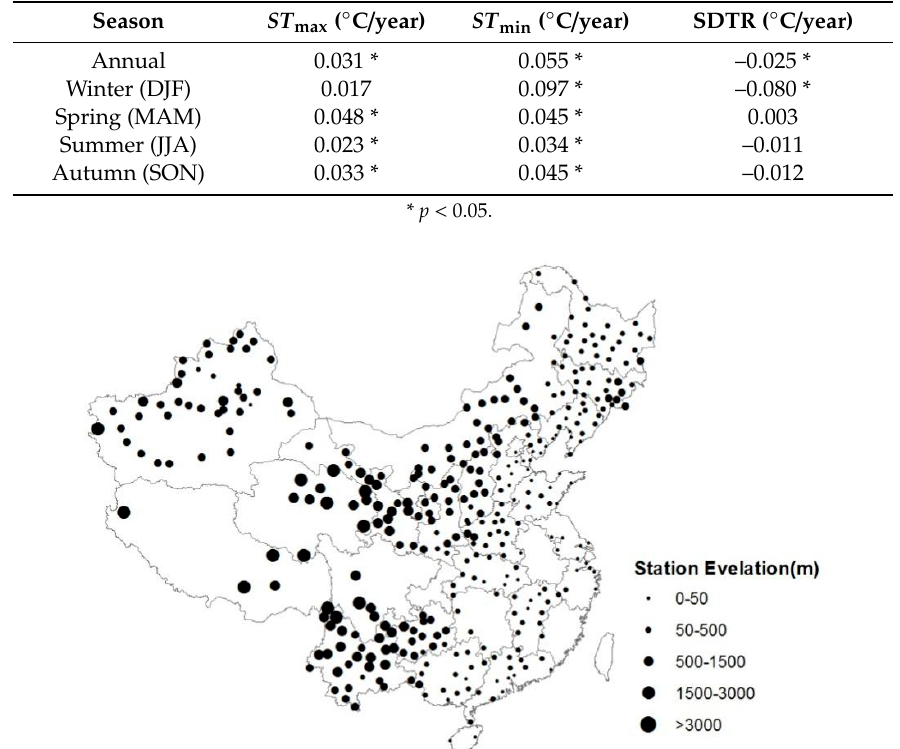
Figure 1. Geographical distribution of the 360 weather stations used in this